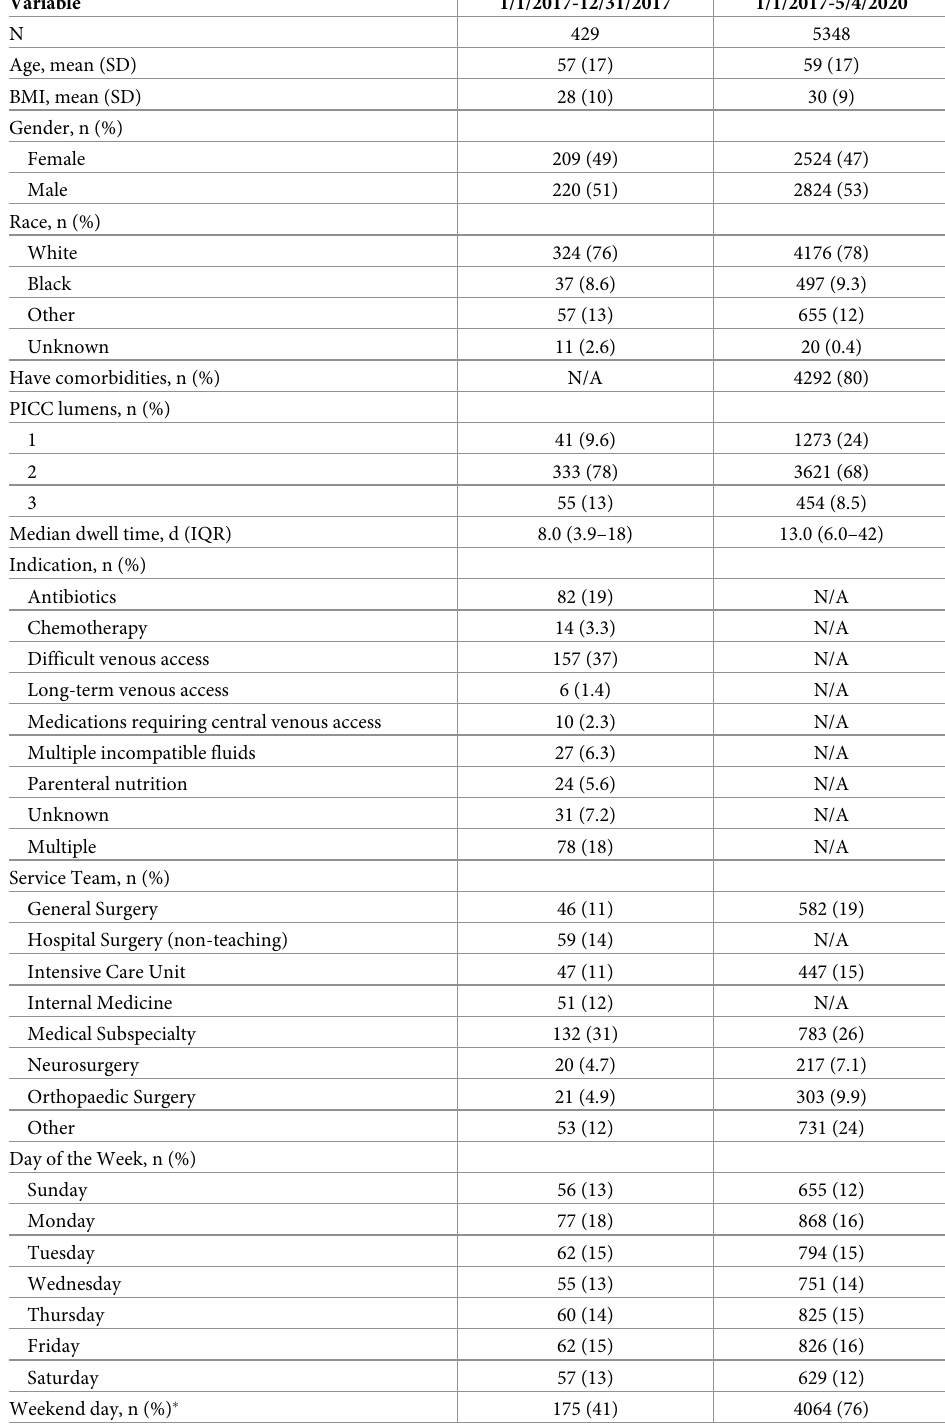
Table 1. Characteristics of patients and